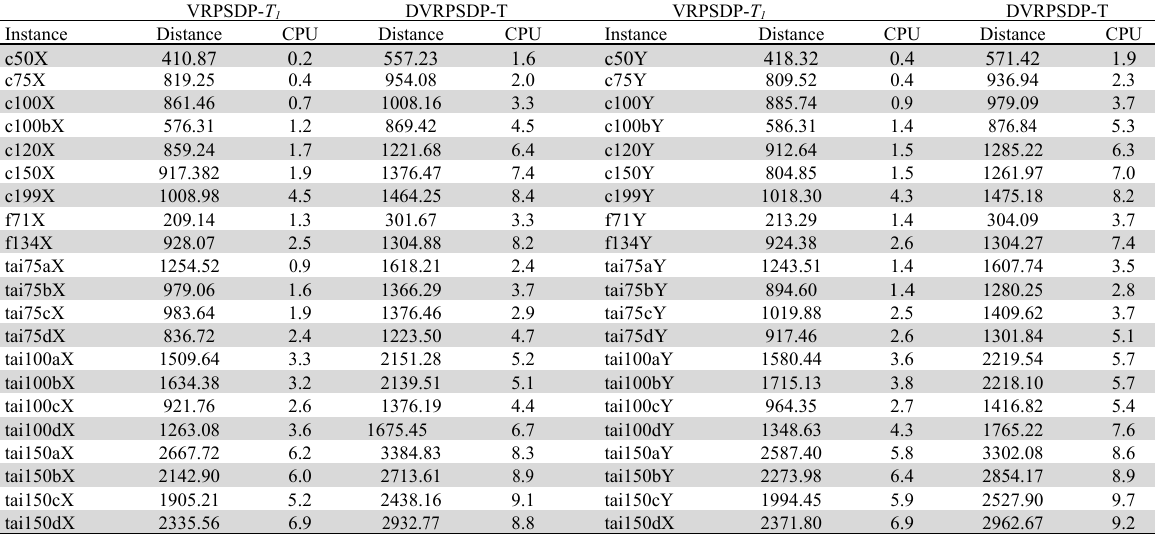
Memetic Algorithm results for VRPSDP and